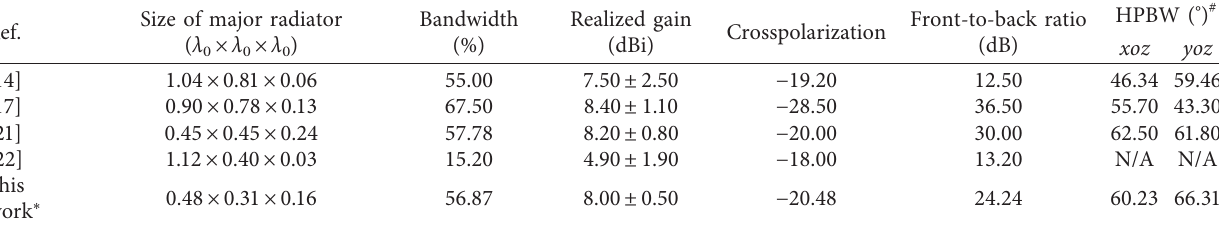
Figure 7: Simulated and measured radiation patterns of the proposed antenna: (a) 3.0GHz, (b) 3.6GHz, and (c) 4.8GHz. Table 2: Comparison with bandwidth enhanced